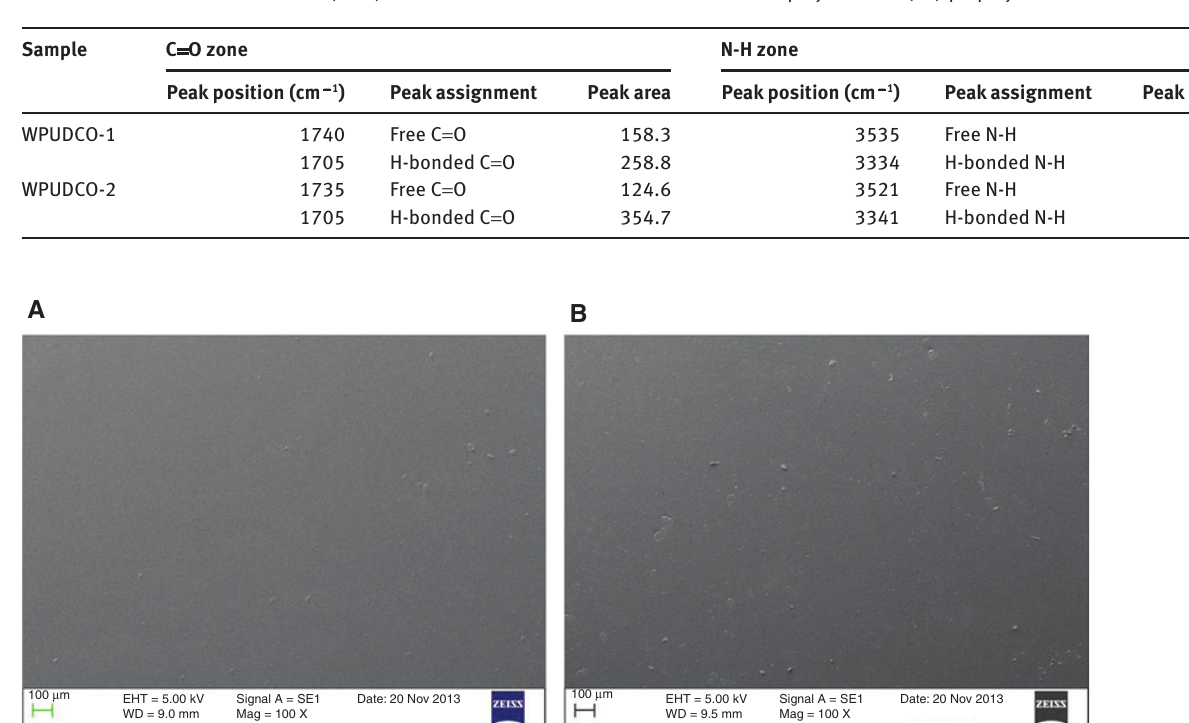
Figure 8: Scanning electron microscopy (SEM) images of polyurethane (PU)-prepolymer (A) WPUDCO-1 and (B) WPUDCO-2.